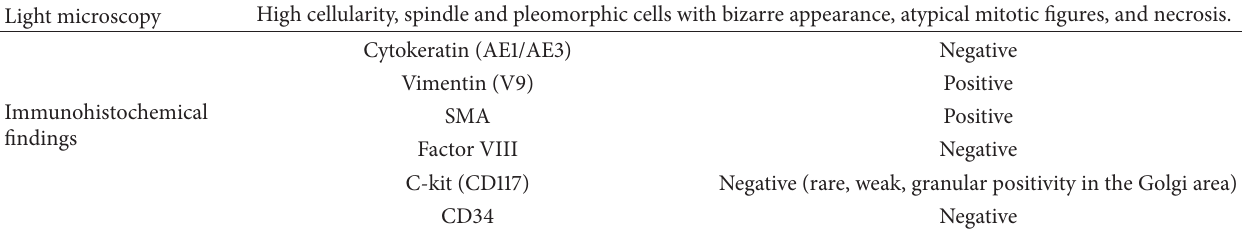
Table 1: Histopathological findings of sarcomatoid tumor in our